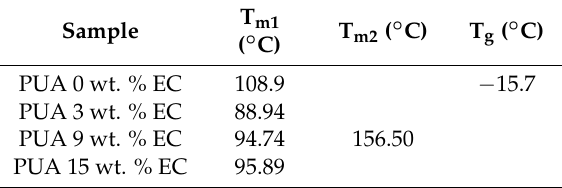
Table 4. Tm of PUA electrolyte with EC.